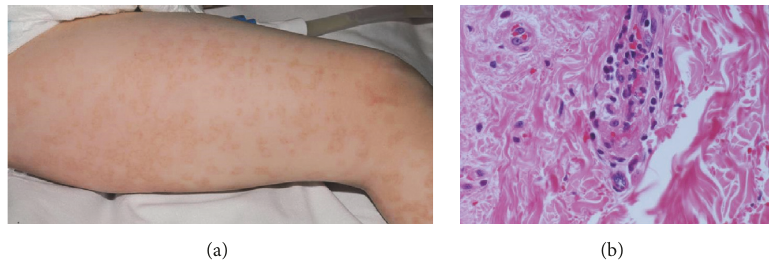
Figure 1: (a) Vasculitic rash with a distinct circinate pattern. (b) Photomicrograph of skin biopsy demonstrating inflammation affecting the superficial and deep dermal small vessels, comprising predominantly mononuclear inflammatory cells, but with focal destruction of the vessel walls with fibrin deposition, red cell fragmentation, and scattered nuclear fragments (haematoxylin and eosin, original magnification ×